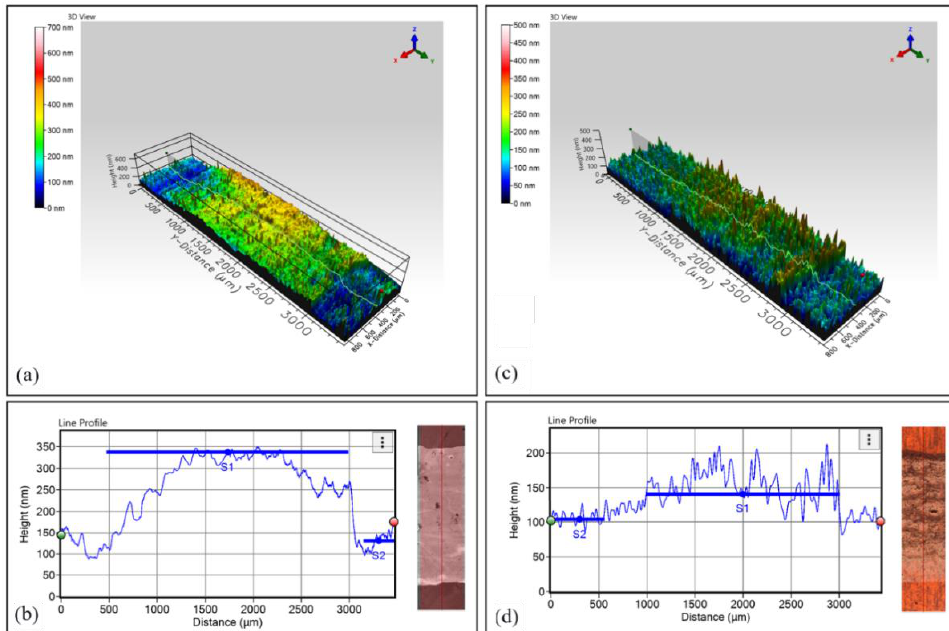
Figure 5. 3D measurement for graphene ( a ) and f -rGO ( c ) and height profile measurements for graphene ( b ) and f -rGO ( d ). The insets show a top view of the areas for which the 2D height extraction was performed, obtained by Filmetrics TotalFocus™. Linewidth is 800 μm ( b , d ).